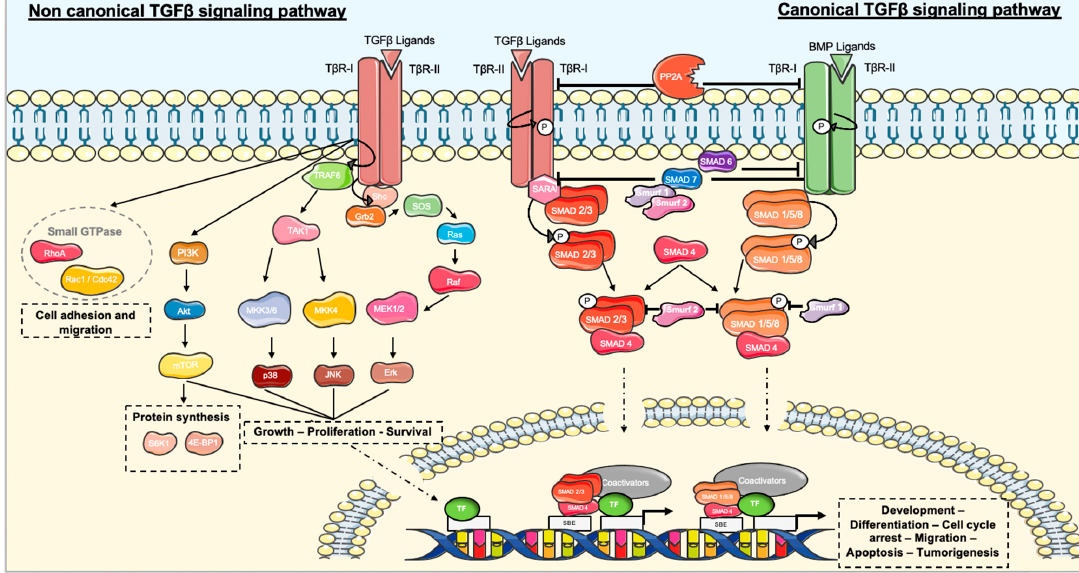
Figure 1. TGF β signaling is activated through BMP or TGF β ligands. Ligands bind the TGF β receptor